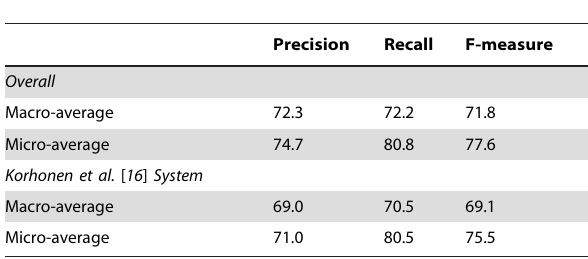
Table 4. Classification results: overall Precision, Recall and F- measure with comparison to the system of Korhonen et al. [16] on the new dataset.